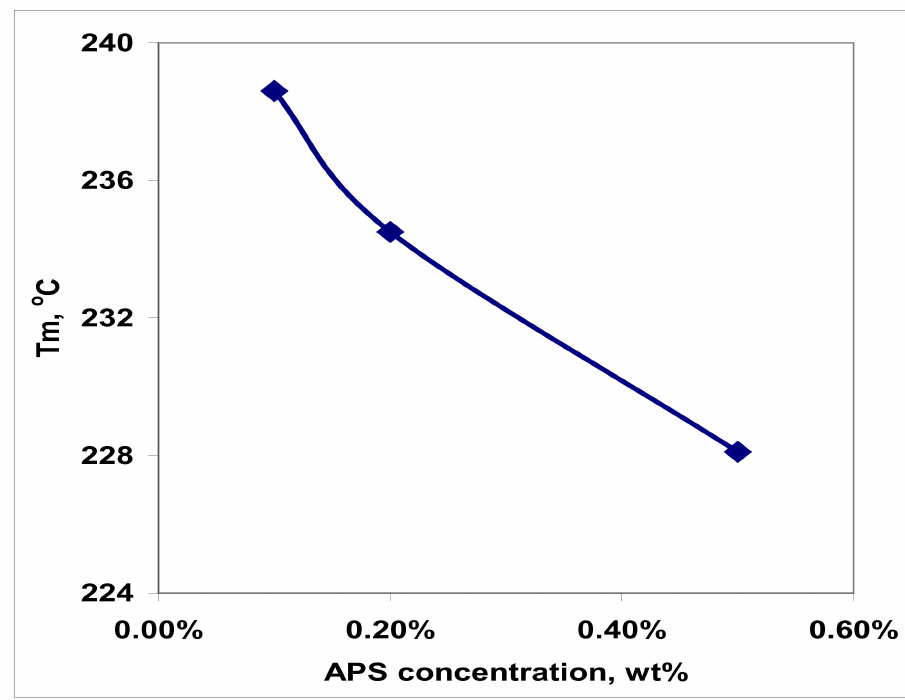
Figure 18. Effect of oxidant concentration on melting temperature of PANi.